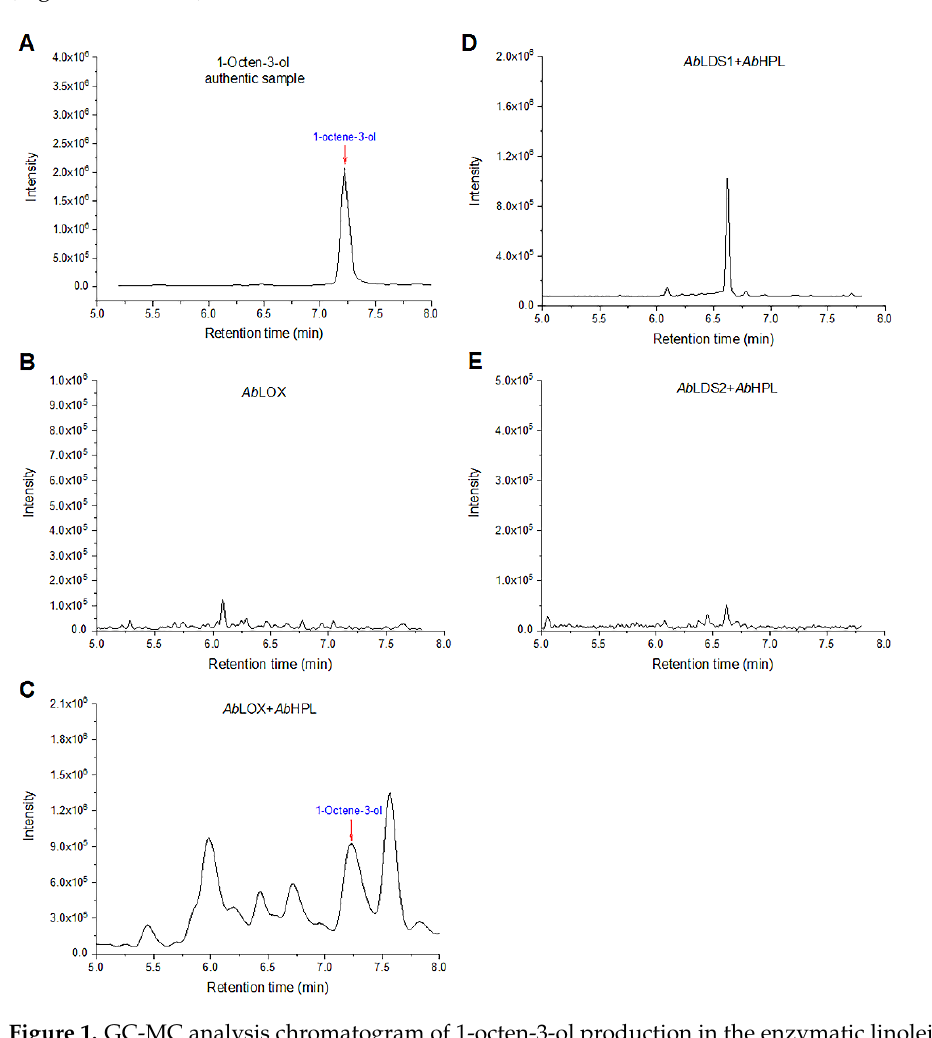
Figure 2. Effects of temperature ( A ) and pH ( B ) on the production of 1-octen-3-ol from linoleic acid by Ab LOX and Ab HPL.